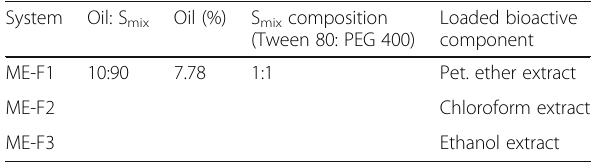
Table 1 Composition of prepared ME